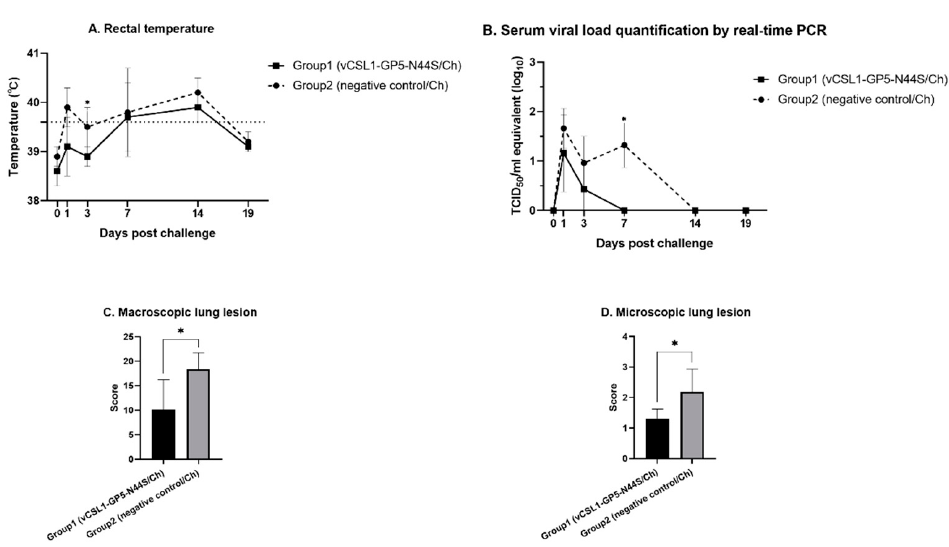
Figure 3. Results of the efficacy evaluation of vCSL1-GP5-N44S. All groups used for safety tests were challenged by intramuscular route inoculation with 10 5.0 TCID 50 /1 mL/dose of KU-PRRSV-2020-002 at 42 d post-inoculation. ( A ) Rectal temperature measured from 0 to 19 d post-challenge. ( B ) Viral RNA load in serum collected from 0 to 19 d post-challenge, determined by PRRS-specific RT-qPCR. ( C ) Macroscopic lung lesion and ( D ) microscopic lung lesion scores were evaluated at necropsy. The symbol “*” indicates statistically significant differences from the negative control (* p ≤ 0.05).